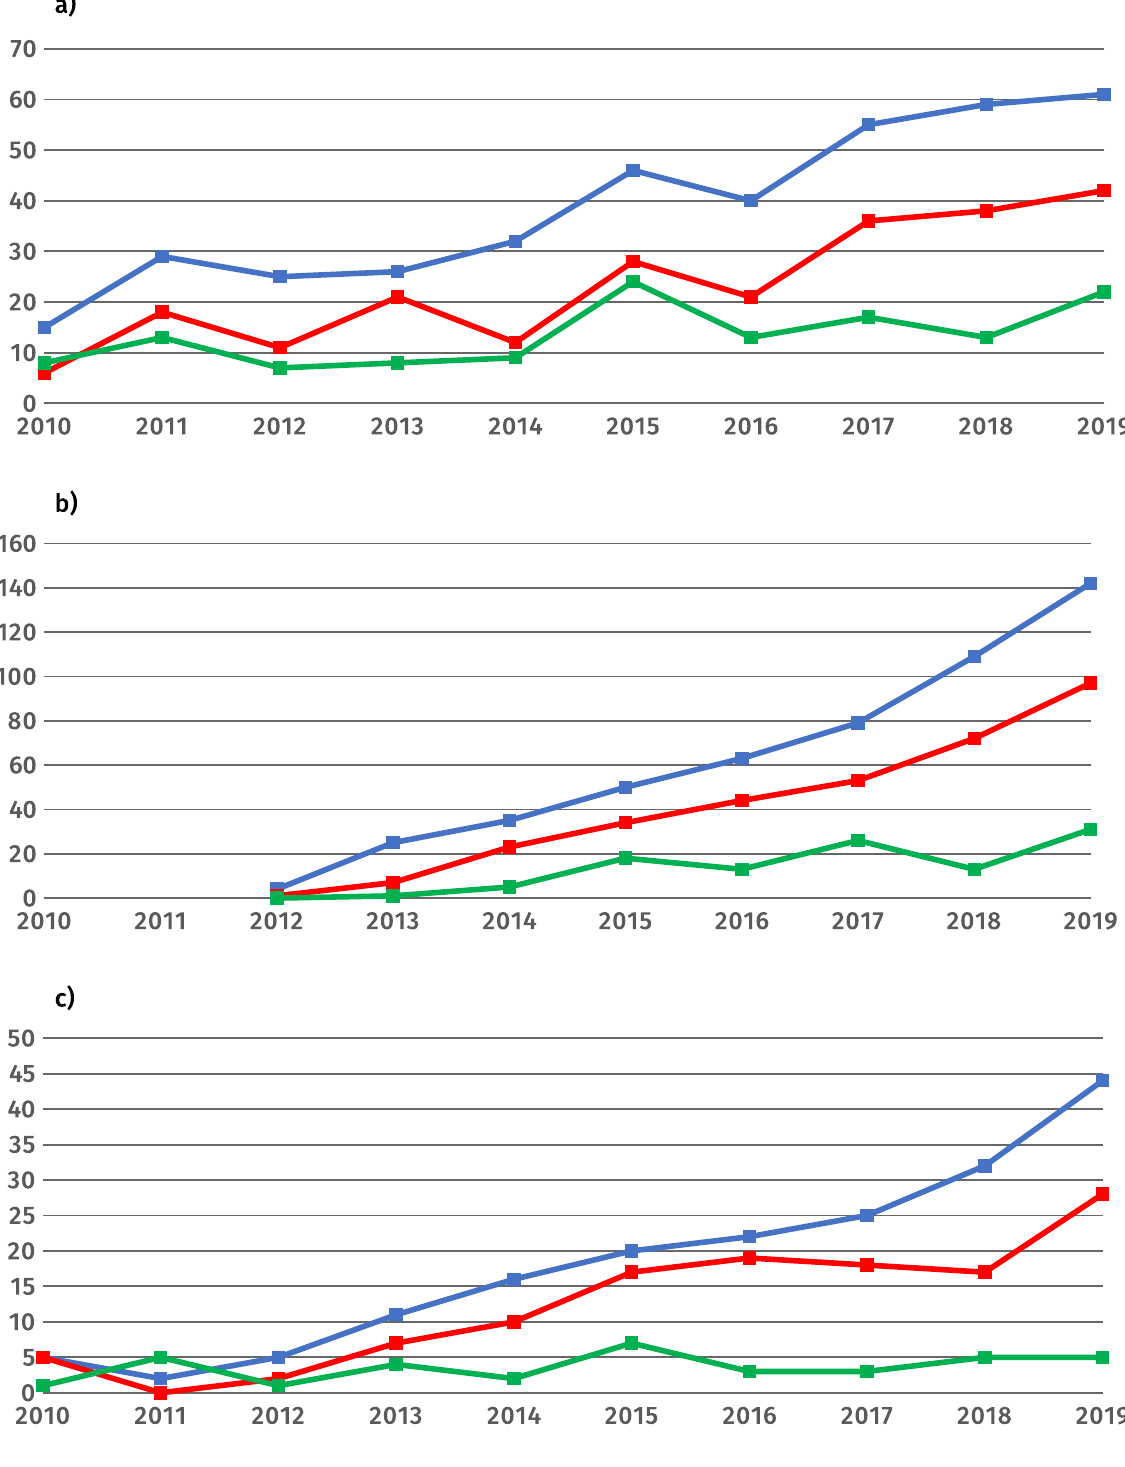
Figure 1. The graphs show the manuscripts received (in blue), rejected (in red), and published (in green) by the Annals of the Brazilian Academy of Sciences (AABC) between 2010 and 2019 in (a) Biomedical, (b) Health and (c) Social